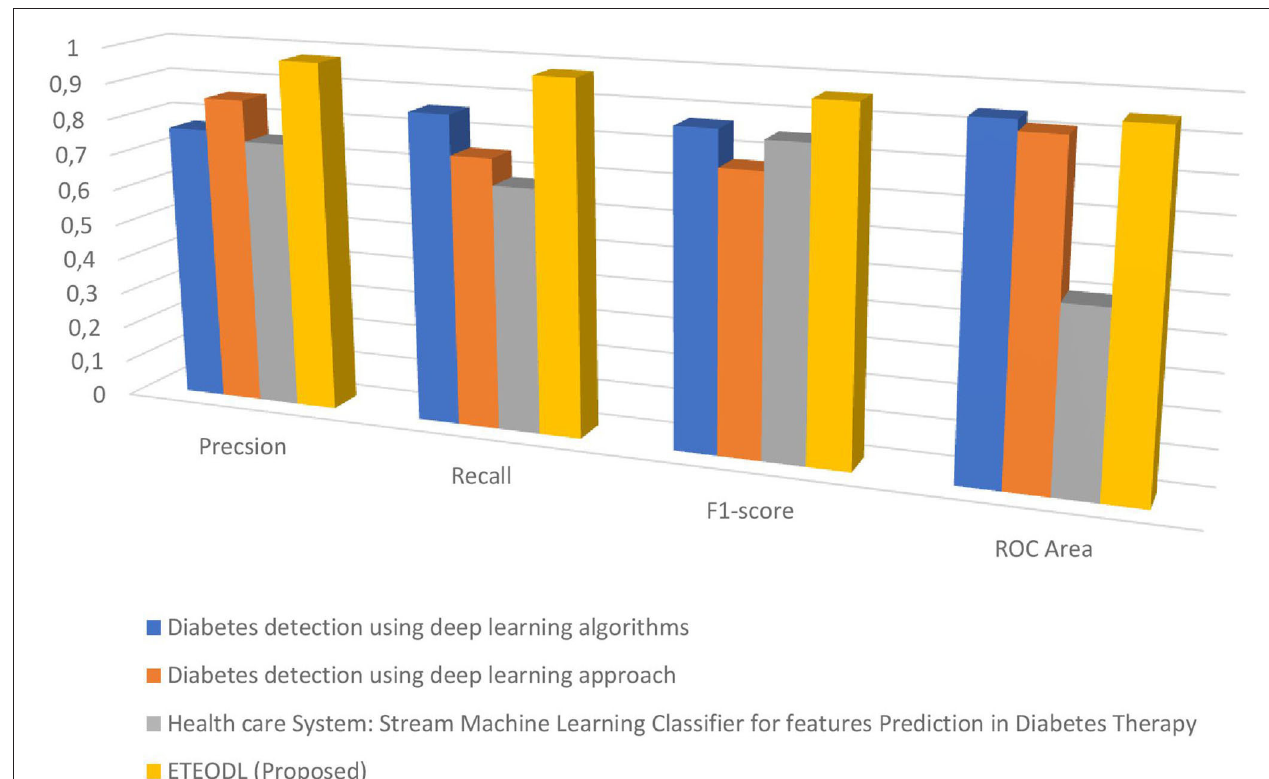
FIGURE 7 | Comparison of precision, recall, f1-score, and roc area.